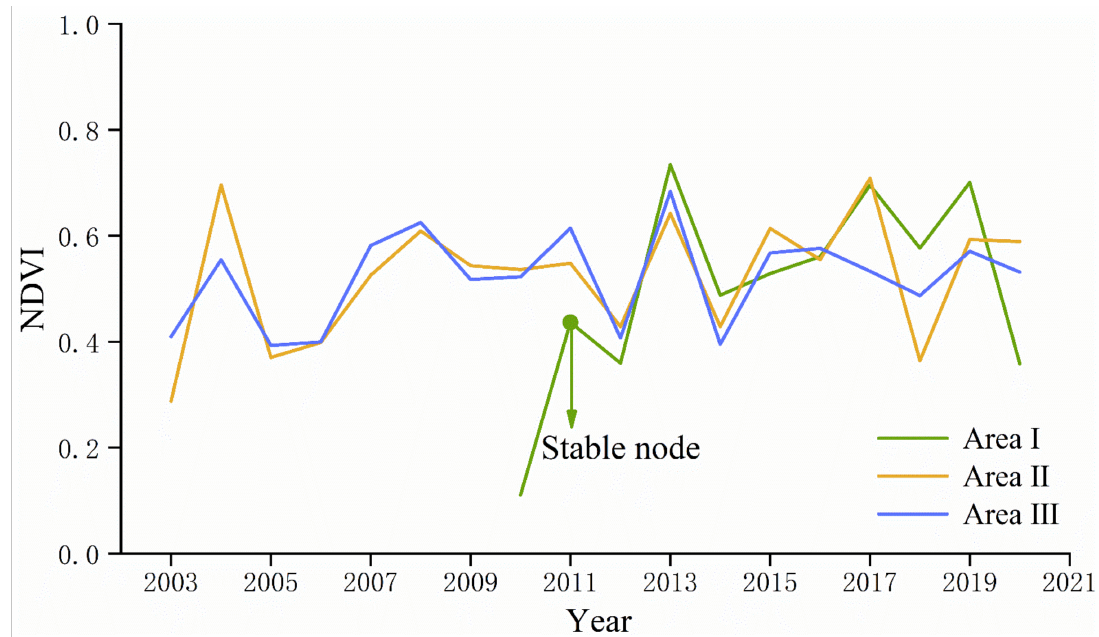
Figure 8. Annual average of NDVI in the “typical area” (area I) and the “problem areas” (areas II and